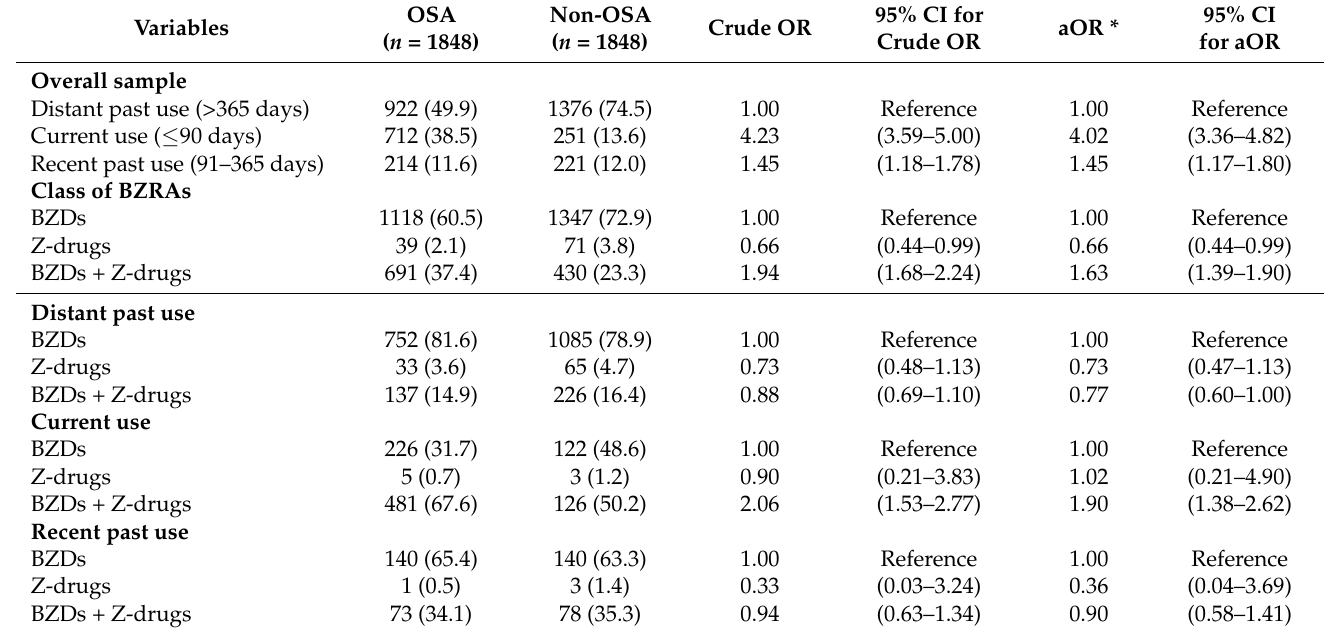
Table 2. Use of BZRAs and risk of OSA development ( n =